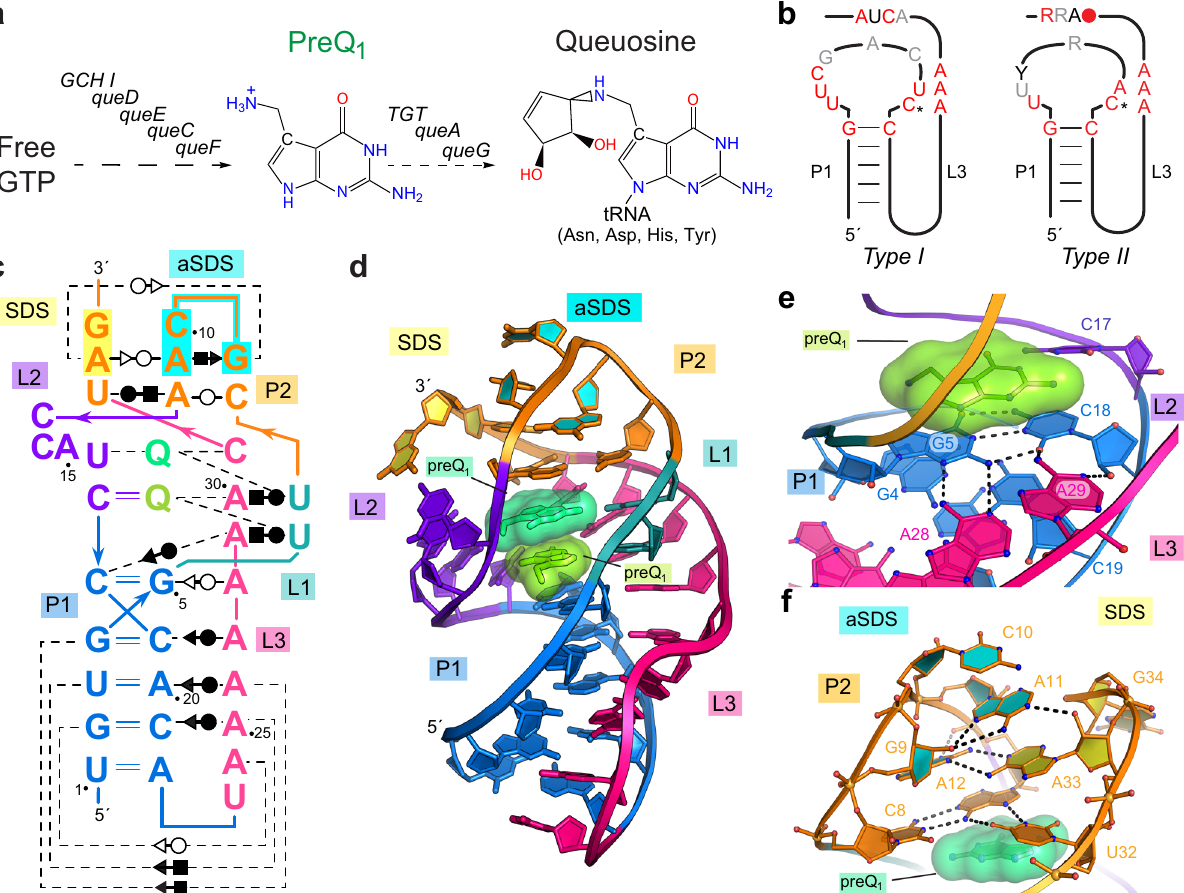
Fig. 1 Queuosine biosynthesis, the preQ 1 riboswitch consensus model and co-crystal structure of the Carnobacterium antarcticus ( Can ) riboswitch. a The queuosine (Q) biosynthetic pathway proceeds through the 7-deazapurine metabolite preQ 1 69 . b PreQ 1 -I riboswitch subtypes shown as secondary structures based on covariation 27 . Red, black and gray positions indicate 97, 90, and 75% sequence conservation. Asterisk indicates a speci fi city base predicted to recognize preQ 1 . c Secondary structure of the Can riboswitch. Colors correspond to speci fi c pseudoknot base pairing (P) and loop (L) sequences. PreQ 1 is depicted as “ Q ” . Noncanonical pairing is indicated by Leontis – Westhof symbols 70 . The Shine-Dalgarno sequence (SDS) and anti-(a) SDS are highlighted in yellow and cyan. d Ribbon diagram of the global Can riboswitch fold. e Binding pocket fl oor overview wherein fl oor bases comprise the A28 • G5-C18 base triple. Dashed lines depict hydrogen bonds here and elsewhere. f Overview of the pocket ceiling, which comprises the U32 • A12 • C8 base triple. The view highlights P2 bases in the aSDS and